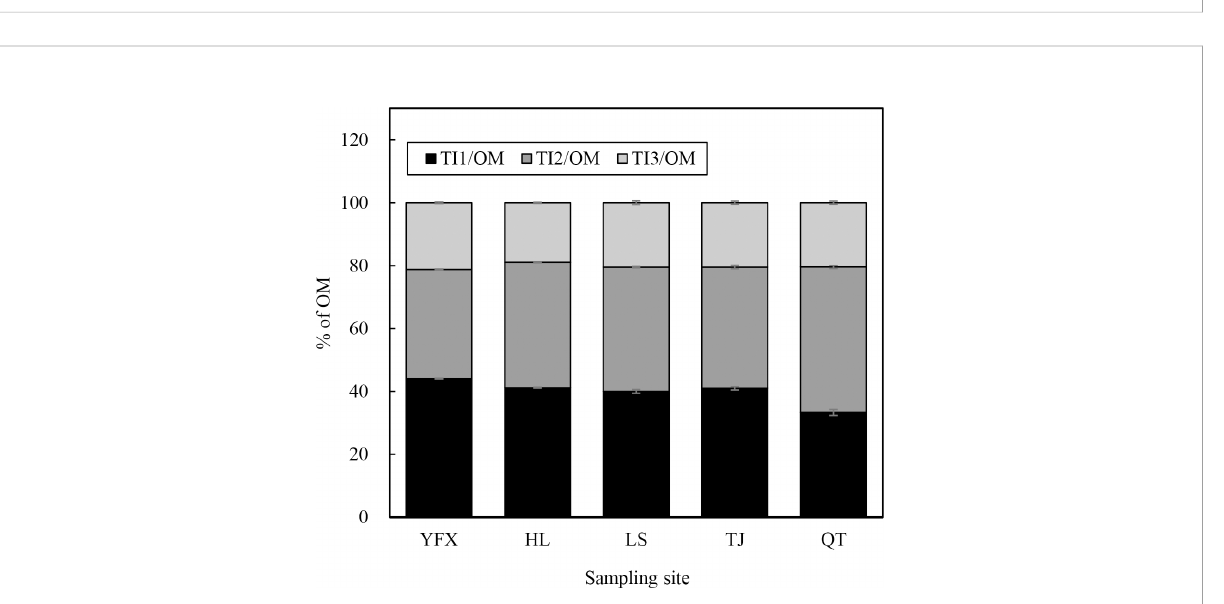
FIGURE 5 Thermal intervals (TIs) in total organic matter (OM) across all location was represented as TIs/OM. TIs represent distinct organic matter components from TGA. Values represent mean ±